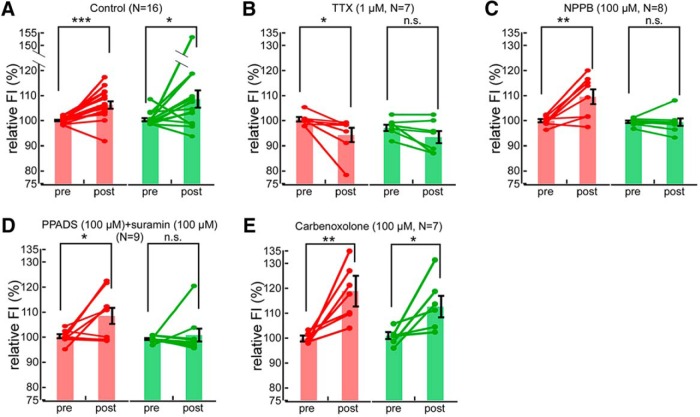
Investigating roles of VAACs in AP-induced axonal swelling and subsequent migration of microglial processes to the periaxonal area. A–E, Plots of the prestimulus and poststimulus data points for axonal swelling (red) and periaxonal microglial (green) FI, for the control condition (A) and for each of the applied drugs (B–E). Individual, paired data, and mean values (±SEM) are shown. FI was averaged over the prestimulus and poststimulus time points, and these were compared using the paired t test: *p < 0.05, **p < 0.01, ***p < 0.001.